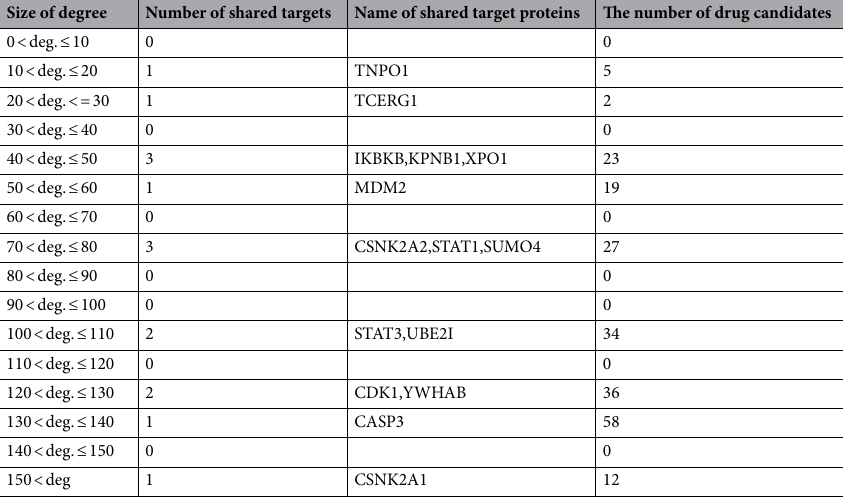
Table 1. Filtered drug candidates with shared target protein degrees for the five viral